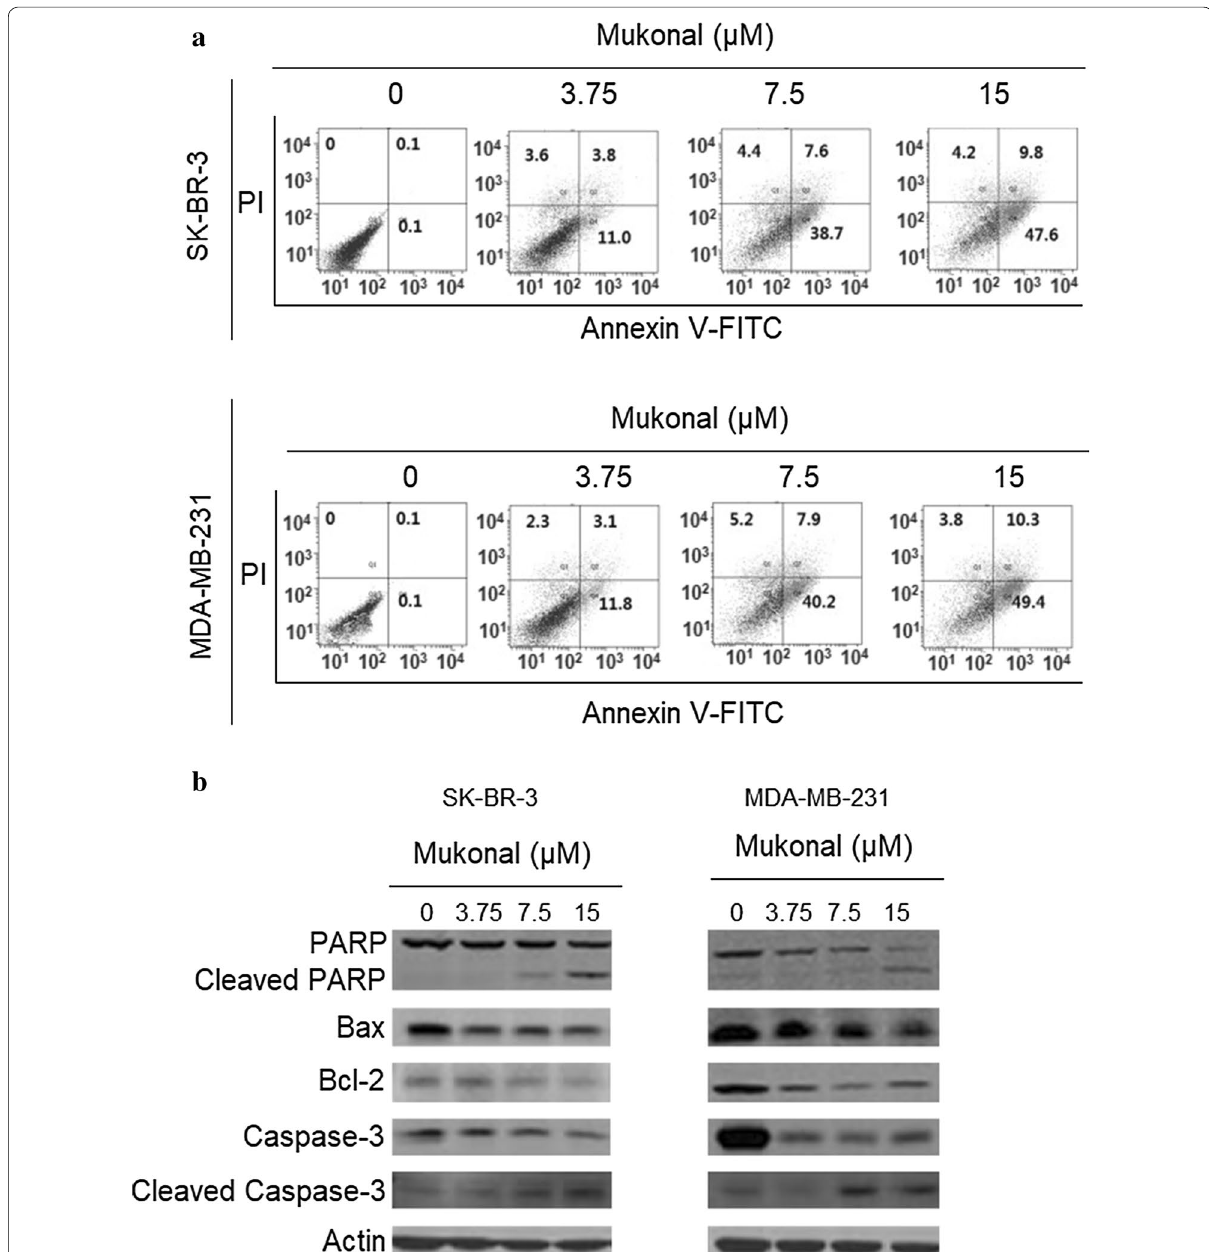
Fig. 3 a Flow cytometric analysis of mukonal treated SK-BR-3 cells. SK-BR-3 cells were cultured in 6-well plates and then subjected to